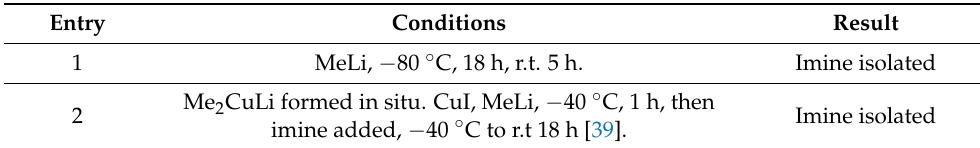
Table 8. Attempted procedures using organolithium reagents.